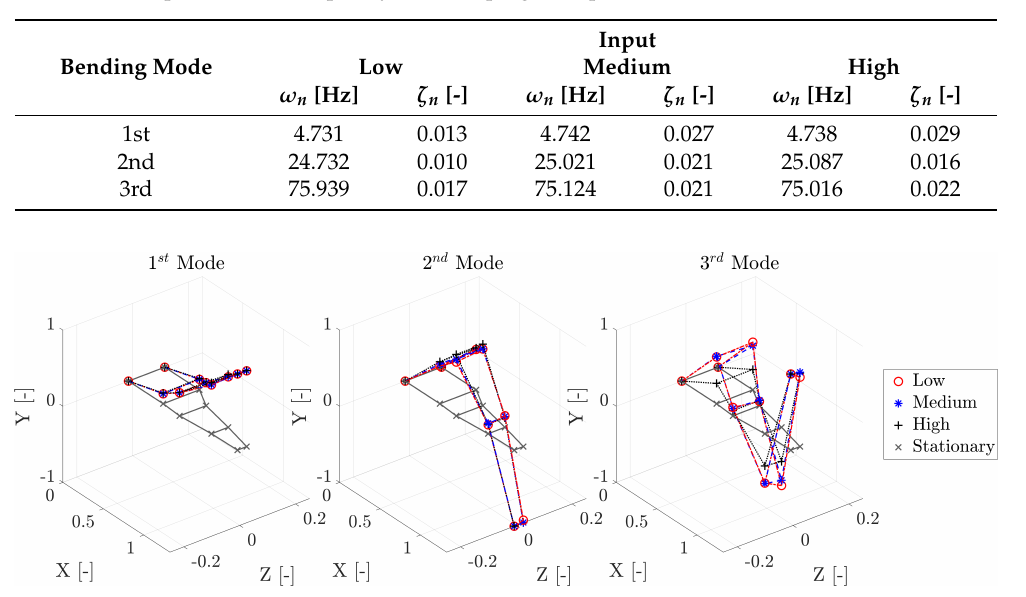
Figure 9. Twin spar: stabilisation diagram of the low-input scenario computed with the following pa- rameters: ∆ f = 1%, ∆ ζ = 5% and MAC = 0.95. The FRF of channels # 3L and 4L are superimposed for further mode visualisation. Table 8. Twin spar: Natural frequency and damping ratio parameters.